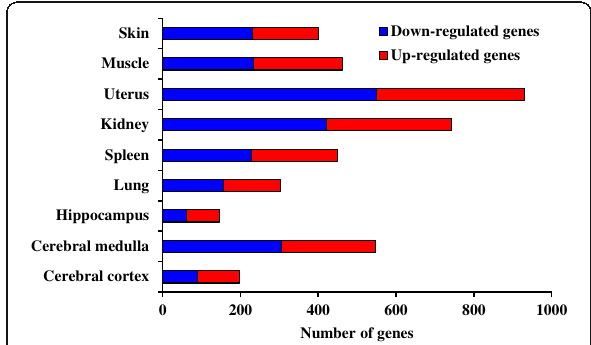
Fig. 1 Number of ST36-regulated genes in various organs. EA stimulation was applied at ST36 acupoint in mice for 15 min. Three hours later, mice were sacrificed and organs were collected for microarray analysis. Data are presented by histograms, and the height of histogram corresponds to the number of upregulated ( red ) and downregulated ( blue )